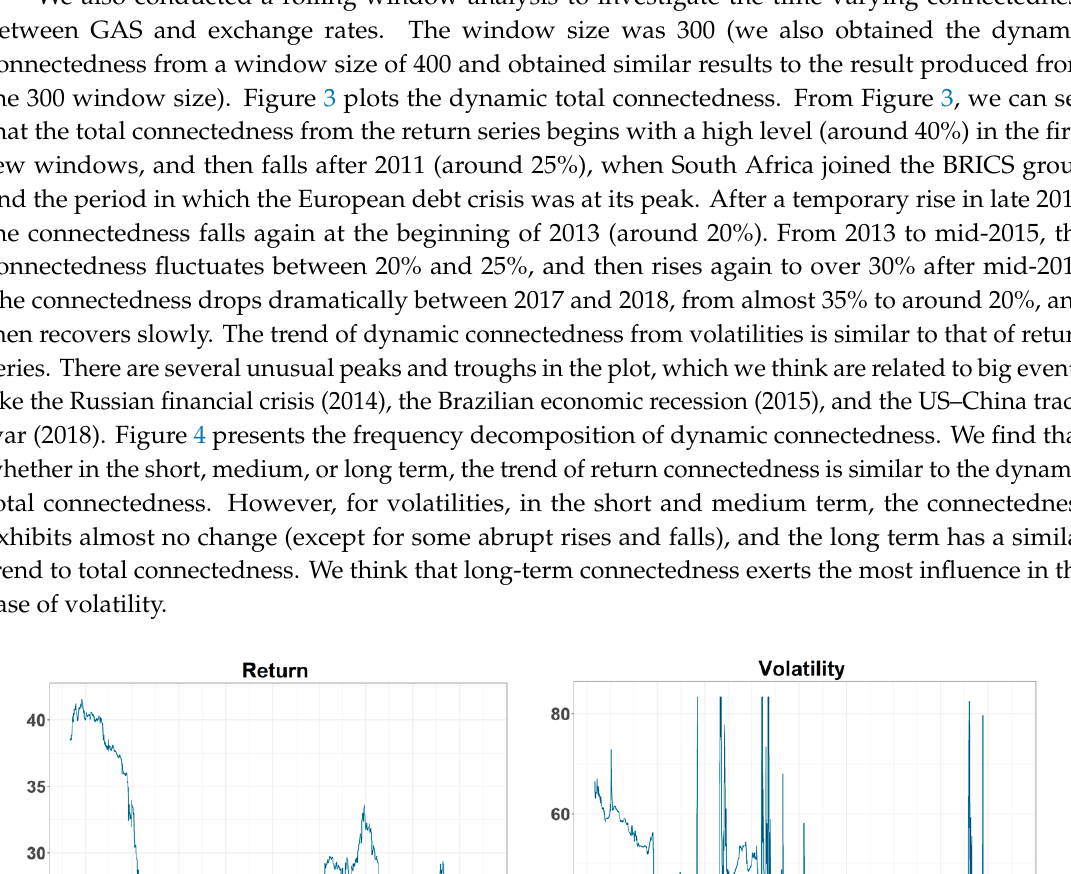
( b ) Figure 4. Frequency decomposition of dynamic connectedness: ( a ) frequency decomposition of total connectedness for return series and ( b ) frequency decomposition of total connectedness for volatilities. Note: BRL, RUB, INR, CNH, and ZAR are Brazilian Real, Russian Ruble, Indian Rupee, offshore Chinese Yuan, and South African Rand, respectively. GASF is the Henry Hub natural gas futures price. The time-varying net pairwise connectedness between GAS and exchange rates return series is plotted in Figure 5. Like the result in Section 4.2, all values were low and almost all of them were below 2.5% in terms of the absolute value, so were negligible. The results from volatilities are